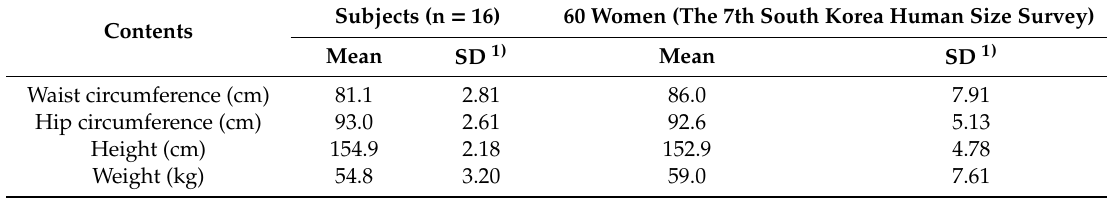
Table 6. Body size of the